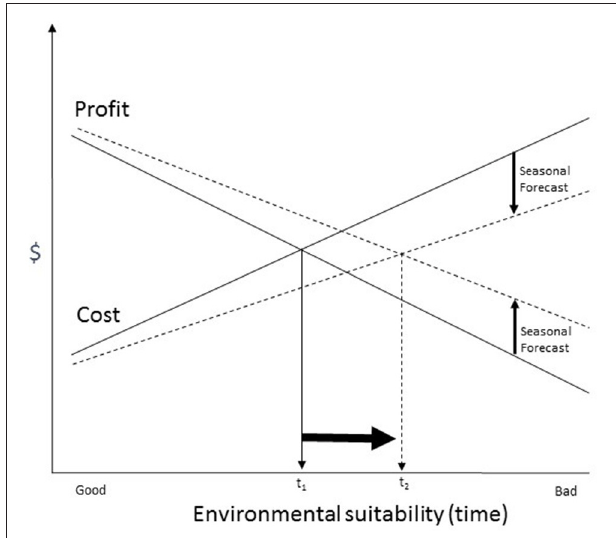
FIGURE 4 | Benefit of seasonal forecasting under changing environmental suitability. In areas where the environmental suitability for the species under consideration is good, profits are high relative to costs. If the environmental suitability at a location declines over time under climate change, costs are expected to increase and profits decrease until a time at which a business would not be profitable (t1). Using seasonal forecasts to provide information on upcoming conditions, businesses should be able to reduce costs and increase profits, relative to no forecast such that they can remain profitable under less suitable environmental conditions for longer (until t 2 ). Beyond this point, conditions are such that relocation (or another adaptation option) is